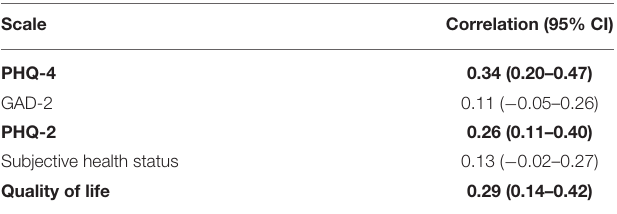
TABLE 3 | Correlation between the IMET differences and other